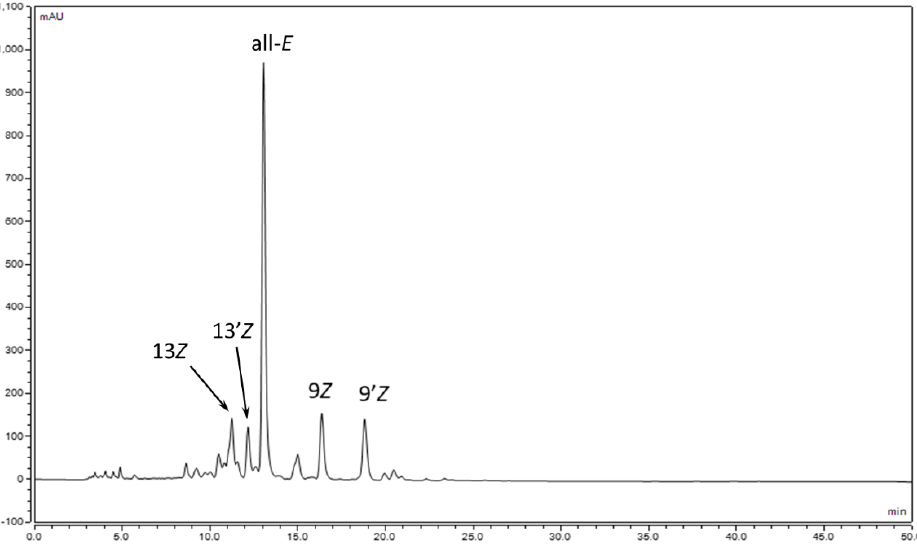
Figure 2. Separation of lutein isomers on a C 30 phase.